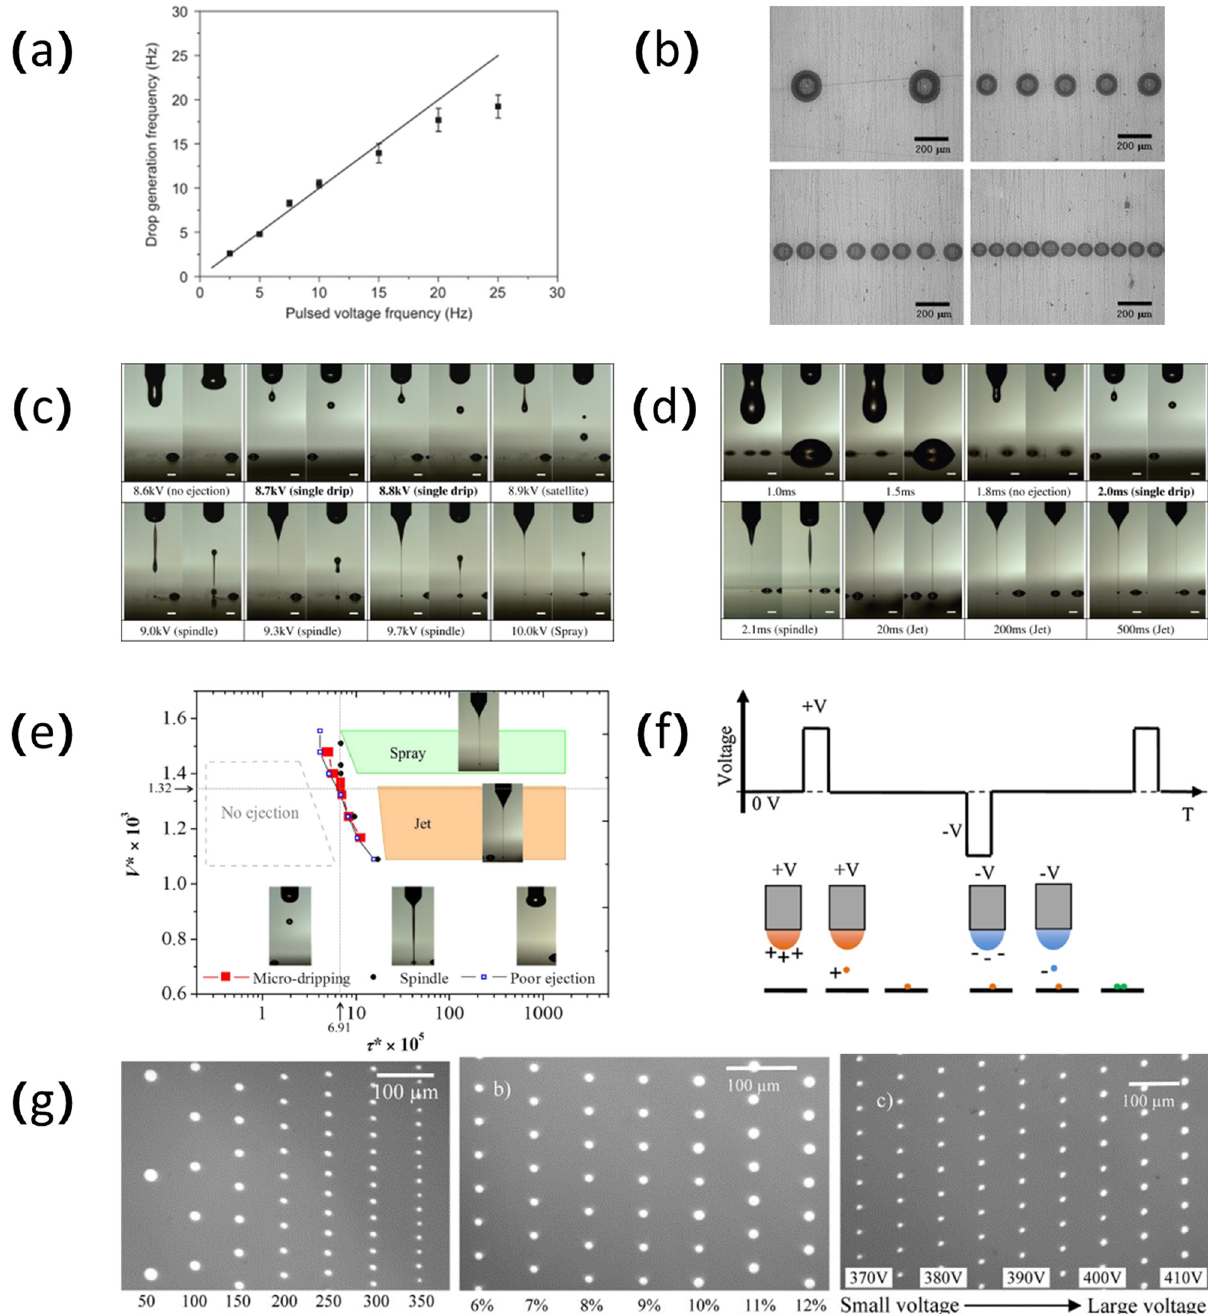
Figure 6: ( a ) Graph of the relationship between droplet deposition frequency and pulse voltage frequency. ( b ) From top to bottom, from left to right, droplet deposition patterns with pulse voltage frequencies of 2.5, 7.5, 15, and 25 Hz. Reproduced from ref. [ 82 ] with permission from Elsevier Ltd. ( c ) The e ff ect of voltage amplitude on injection mode. ( d ) The e ff ect of pulse duration on injection pattern. ( e ) The state diagram of the injection mode based on the dimensionless duration and voltage. Reproduced from ref. [ 84 ] with permission from Elsevier Ltd. ( f ) Typical AC pulse voltage waveform diagram for E - jet printing. ( g ) The in fl uence of AC pulse frequency, duty cycle, and voltage on droplet size. Reproduced from ref. [ 92 ] with permission from between two consecutive pulses. The droplet size is as applied voltage, fl ow rate, surface wettability, and fre - quency. However, repeated experiments require a lot of achieved by repeated adjustments of experimental parameters. The dimensional controllability depends on parameters such time and cost. Park et al. [ 86 ] proposed two mathematical